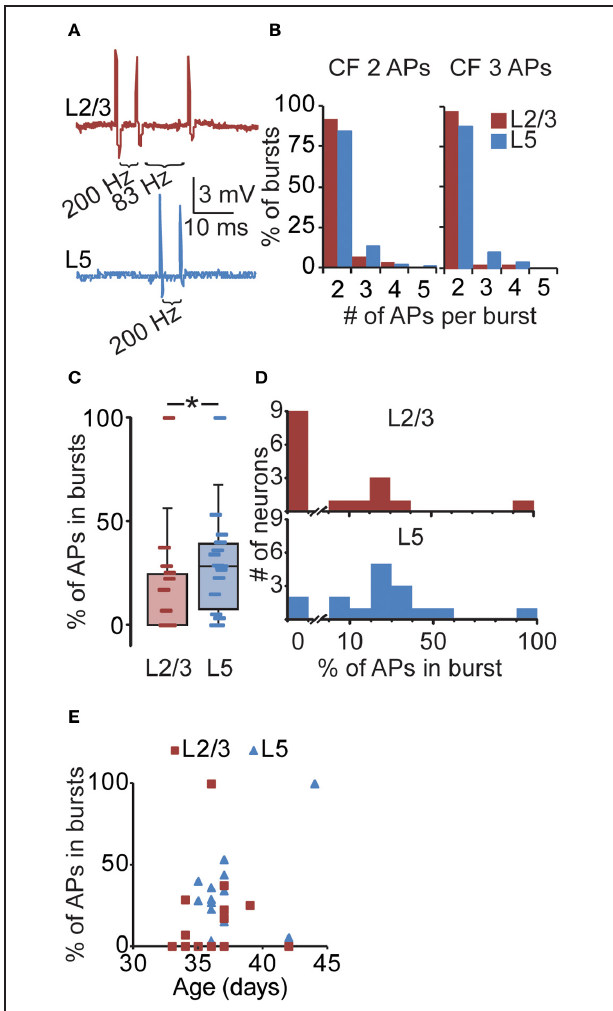
FIGURE 4 | Layer-specific likelihood of suprathreshold bursting in PFC. (A) Upper panel: example of a L2/3 neuron illustrating three consecutive APs at 200 and 83Hz. Lower panel: example of a L5 neuron illustrating two consecutive APs at 200Hz. (B) The number of APs that are part of supracritical bursts for CF values obtained with two or three somatically evoked APs (see Figure 3 ). For example, the CF for L5 using two somatically evoked APs is 46Hz ( Figure 3 ). In our in vivo L5 recordings, we subsequently selected bursts exceeding the CF of 46Hz and determined that 84% of such bursts consisted of two APs. Only a minority of supracritical bursts consisted of three, four, or even five APs at frequencies > 46Hz. Note that the majority of supracritical bursts in L2/3 and L5 neurons thus contain two APs, both when using the CF for 2 spikes (L2/3: 67Hz, L5: 46Hz; left panel) and the CF for three spikes (L2/3: 81Hz, L5: 57Hz; right panel). (C) For individual PFC recordings from awake rats, we subsequently determined the percentage of APs that are part of supracritical bursts, defined as spiking frequencies exceeding the CF determined in vitro ( Figure 3 ) and plotted these values in a box plot. (D) Same data as (C) , but plotted in a histogram (L2/3: upper panel, L5: lower panel), again illustrating the percentage of spikes in supracritical bursts for individual L2/3 and L5 neurons in awake rats. For instance, nine L2/3 neurons did not show any supracritical bursts compared to two L5 neurons. In general, the percentage of APs that were part of supracritical bursts was higher for L5 neurons compared to L2/3 neurons. *denotes p < 0 . 05. (E) The relationship between the occurrence of bursts and age of the animal for L2/3 and L5